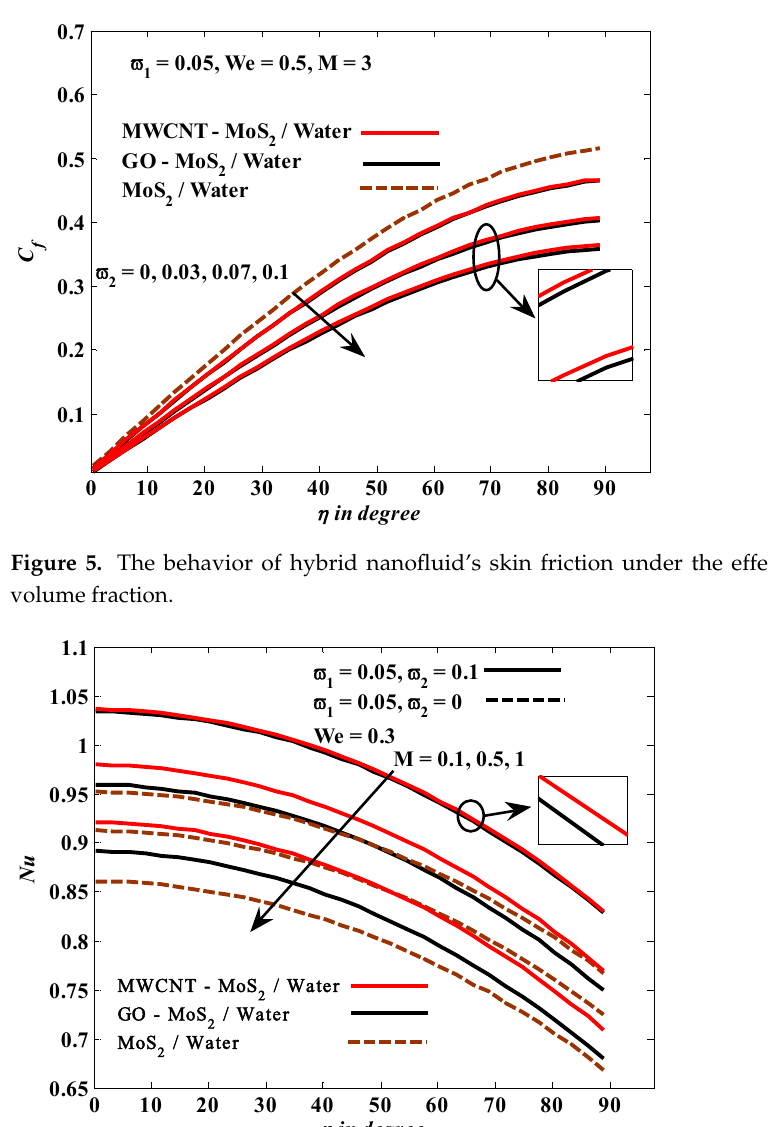
Figure 4. The behavior of mono-hybrid nanofluid’s skin friction under the effect of We.